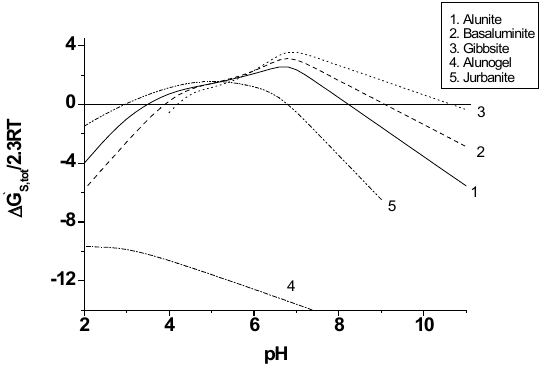
Total Gibbs energy versus рН in the system “saturated aqueous solution – mineral”. Concentrations (mol L -1